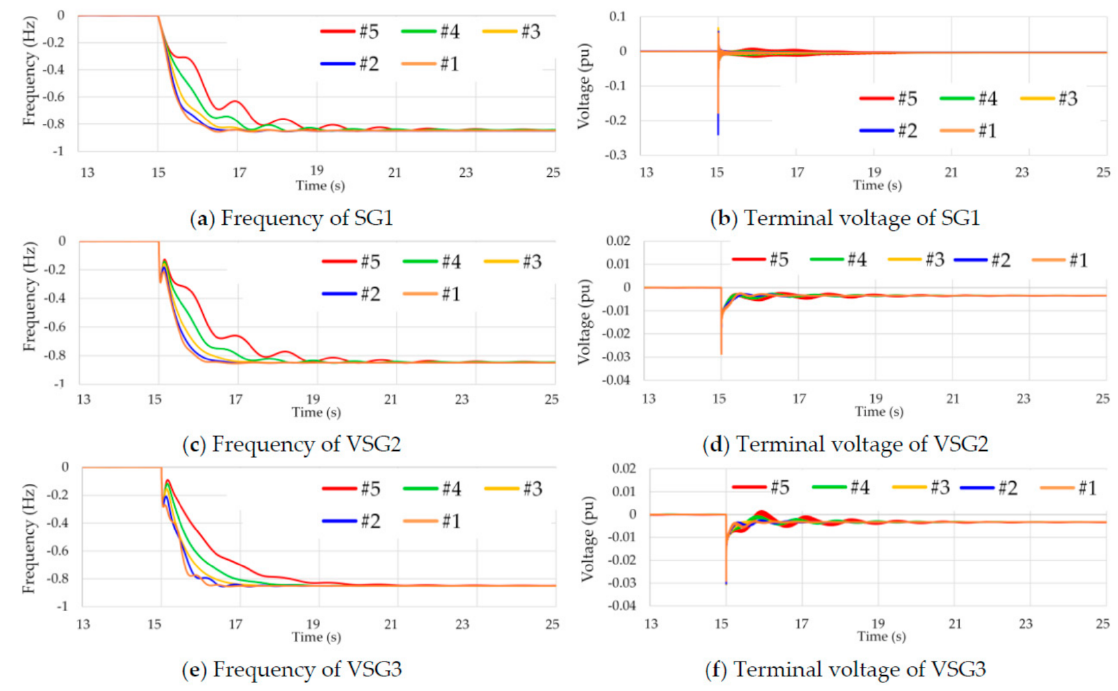
Figure 4. Transient responses of the frequency and voltage for tests 1–5 in Table